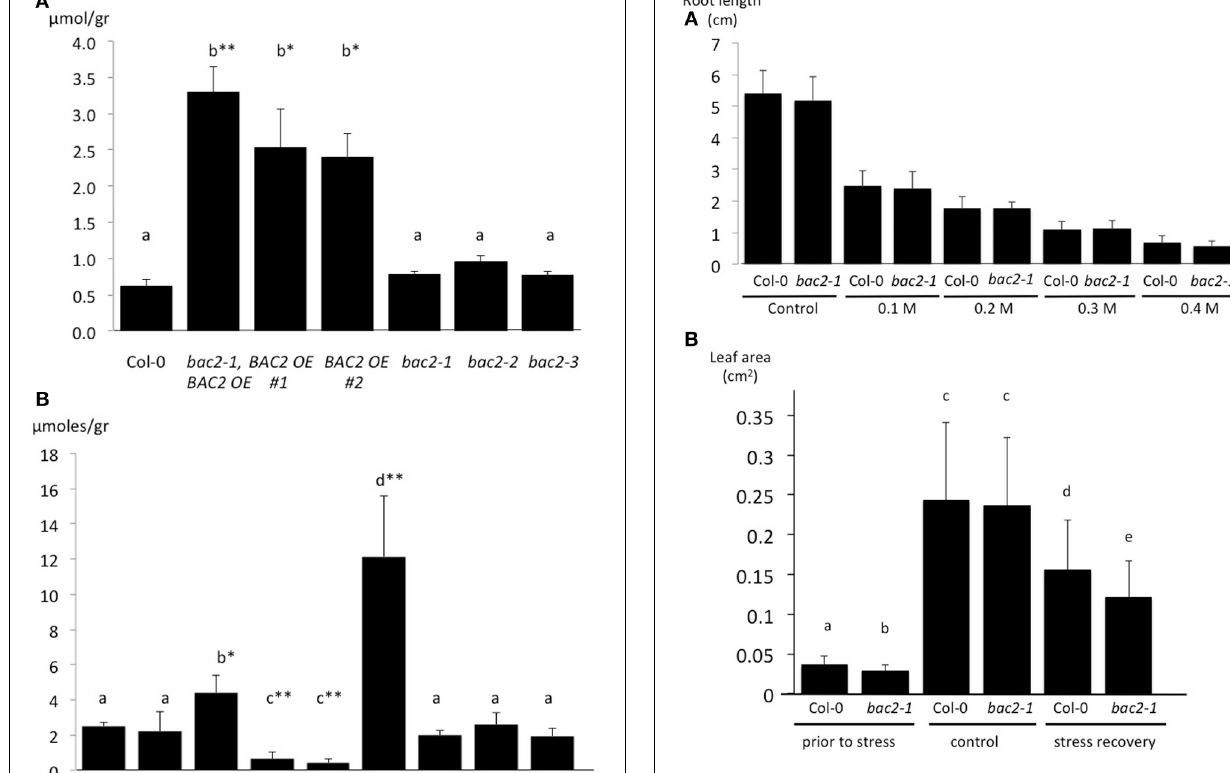
FIGURE 4 | Effect of stress on root length and leaf area growth of Arabidopsis plants. (A) Measurement of Col-0 and bac2-1 root length 9 days after sowing on increasing concentrations of mannitol to trigger an hyperosmotic stress. (B) The area of the first two leaves of 8-day-old Arabidopsis was measured prior to any treatment and 1 week after transfer to soil in either non-stressed control plants or stressed plants (24h on 0.4M mannitol). Col-0, wild type Arabidopsis; bac2-1 , KO mutant bac2-1 . Letters refer to statistically different values with significance of p < 0 . 05 ( n > 40) in the Student t